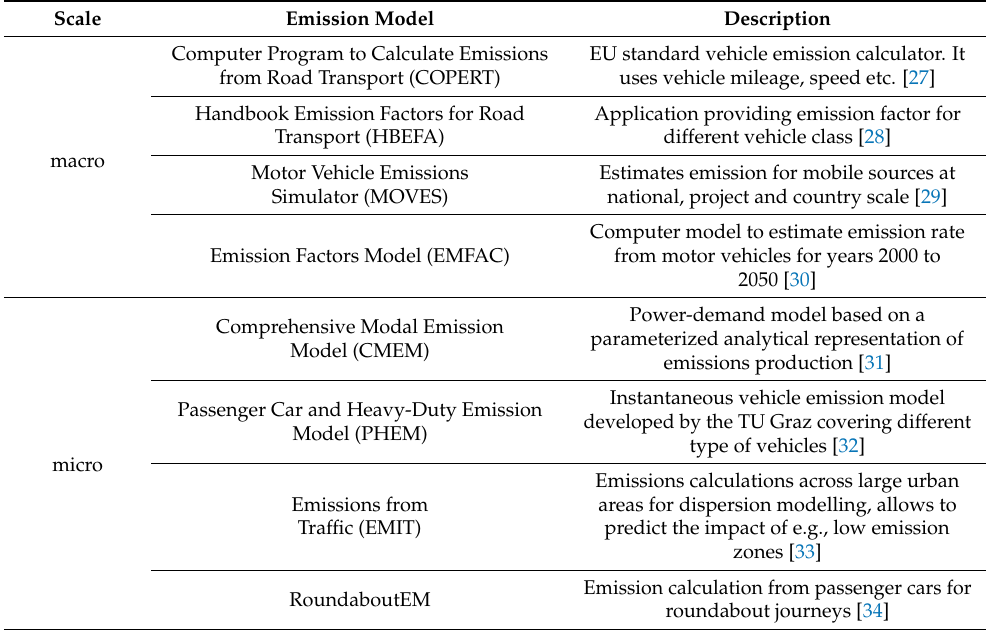
Table 1. Exampled emission models with division to macro and micro